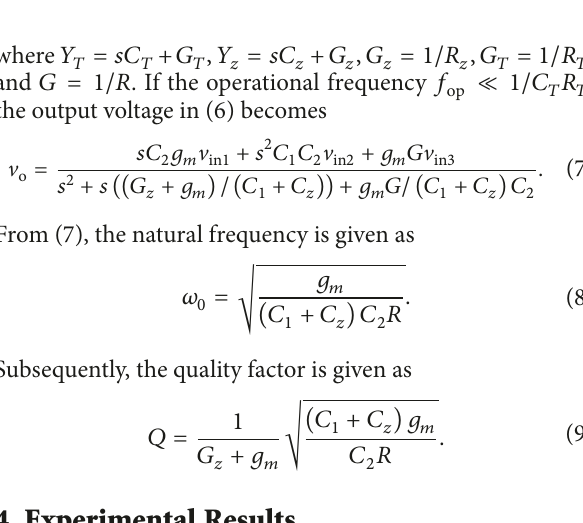
Figure 2: Proposed filter.